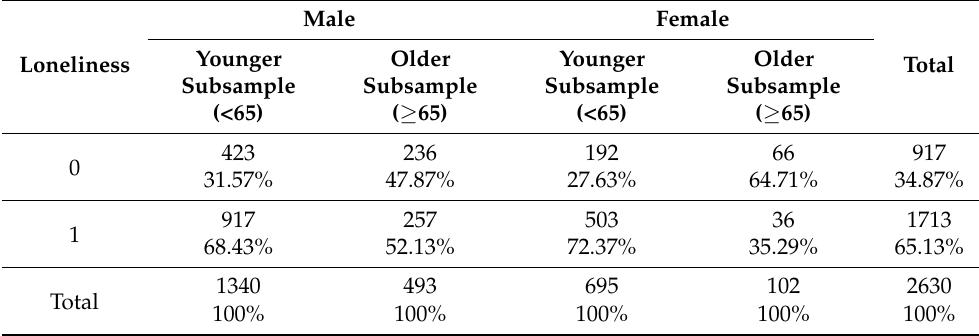
Table 3. Distribution of loneliness by gender and age